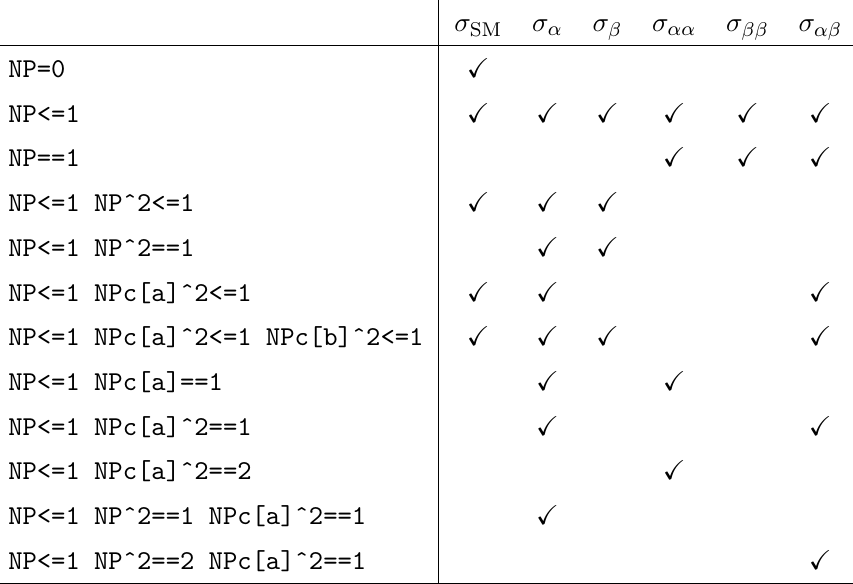
Table 8 . Examples of interaction-order syntax that select different EFT contributions to a generic observable with the dependence given in eq. (8.1), for the case of 2 Wilson coefficients C